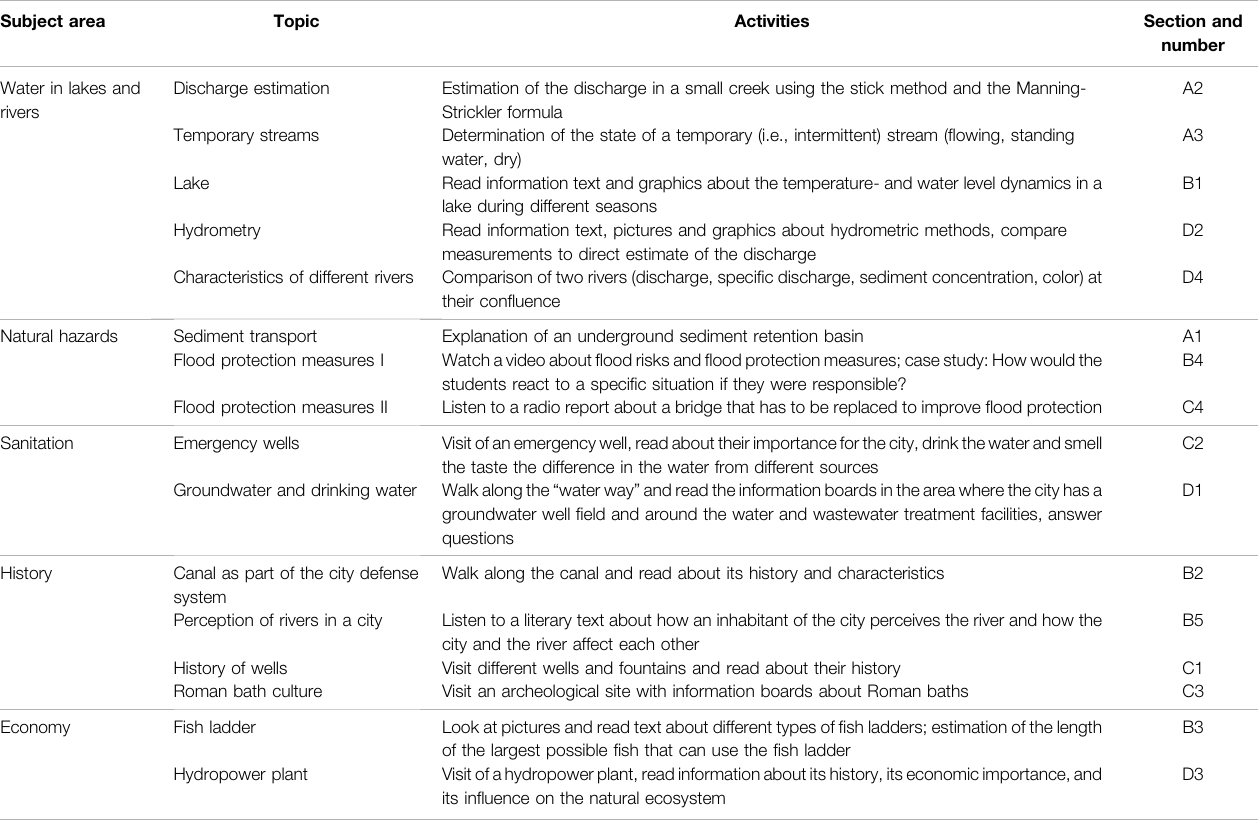
TABLE 1 | Overview of the topics covered in the Water in the city of Zurich excursion and example activities. The section and number indicate the section (A – D) of the excursion and the stop